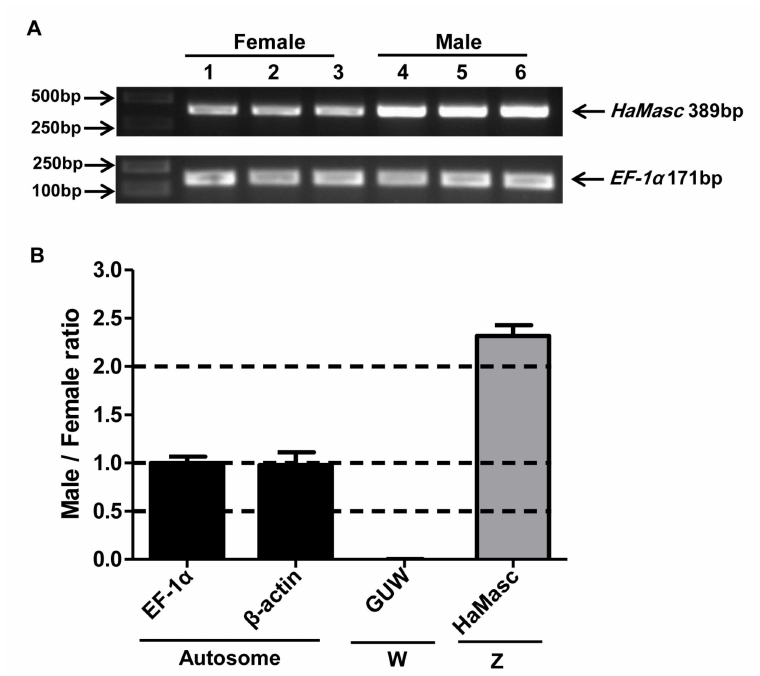
Figure 4. Chromosomal affiliation of HaMasc. ( A ) Genomic PCR gel analysis of HaMasc and EF-1 α . Genomic DNAs extracted from three female pupa (numbered 1, 2, 3) and three male pupa (4, 5, 6) were used as the template to PCR-amplify HaMasc and EF-1 α , respectively. A representative gel image of each gene is presented in ( A ). ( B ) Genomic qPCR analysis of HaMasc , W-linked GUW1 , and autosomal genes EF-1 α and β -actin. The templates (three male DNA samples and three female DNA samples) used for qPCR are the same as for PCR gel